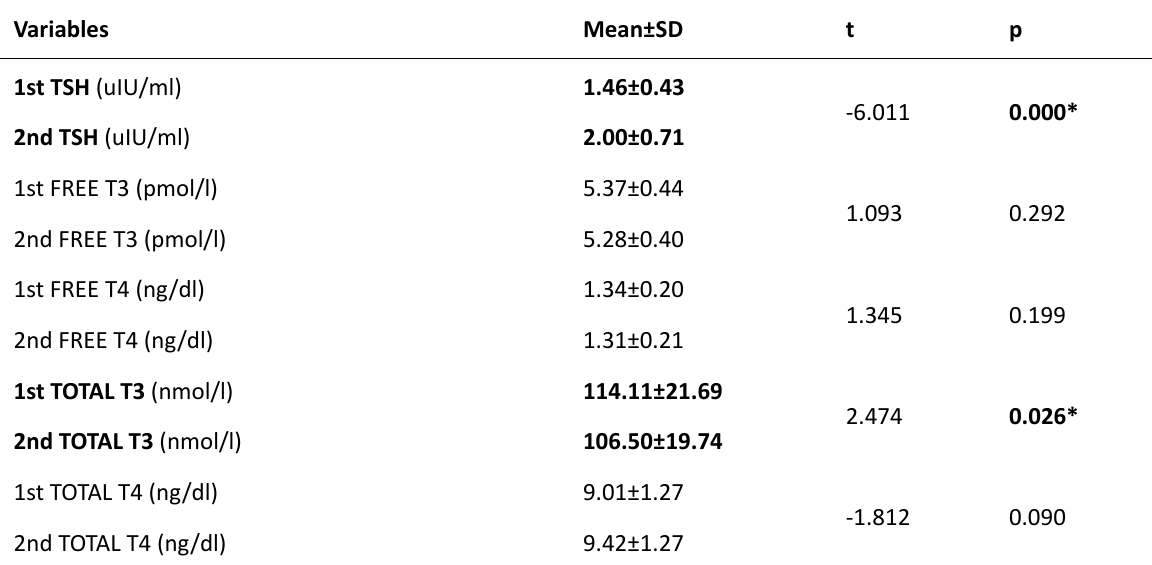
Table 2. Changes in variables pre and post